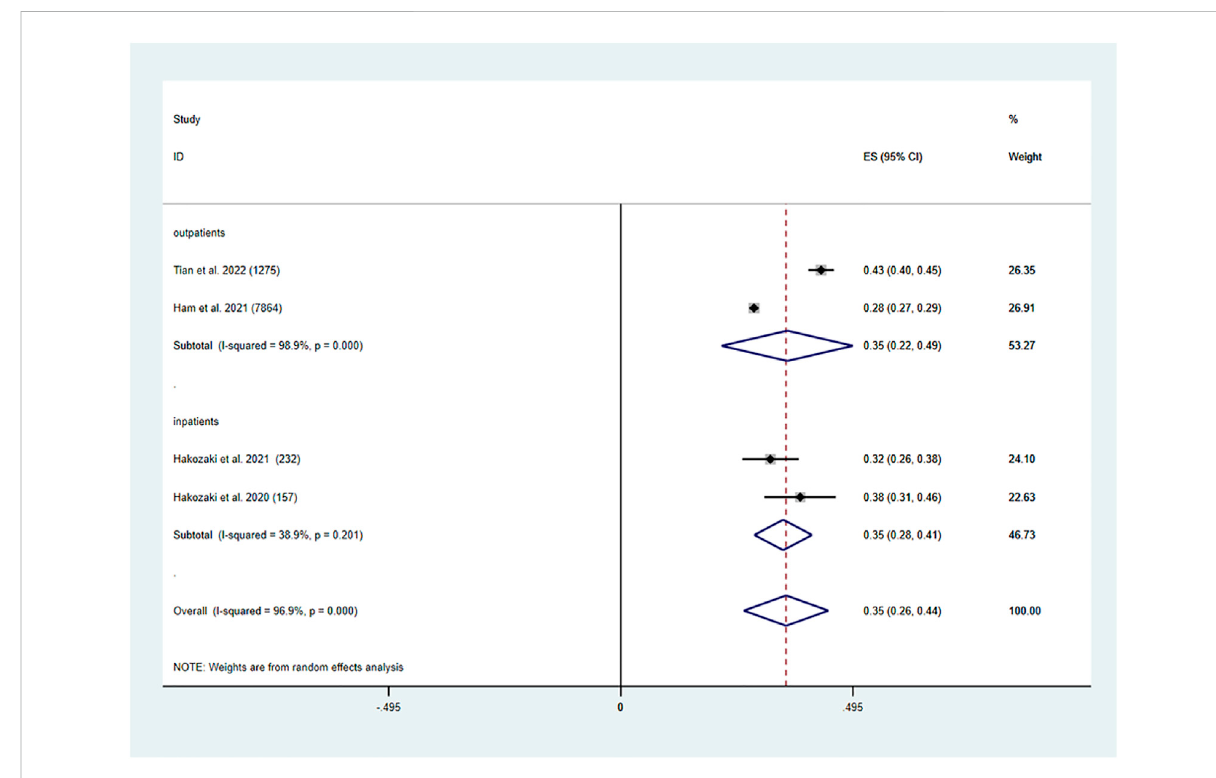
FIGURE 3 Prevalence of PIMs in the older lung cancer population.